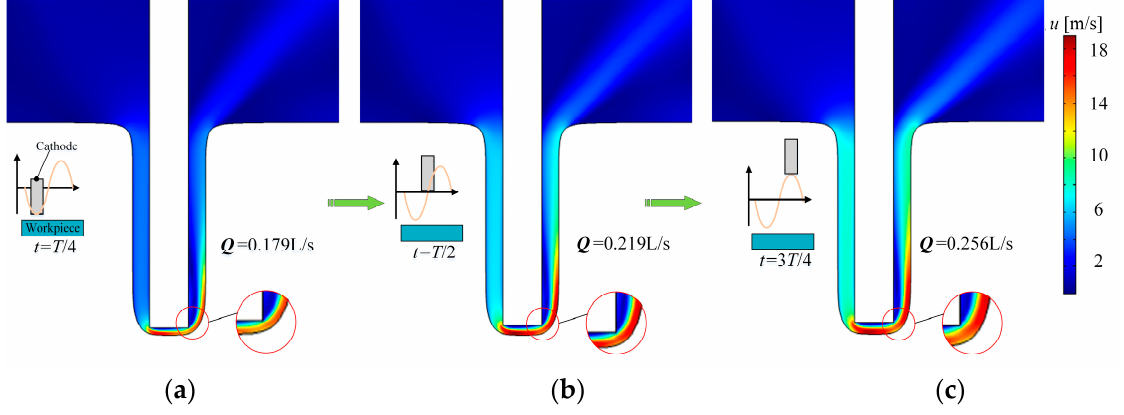
Figure 6. Distributions of electrolyte velocity over time; ( a ) t = T /4. The nearest cathode position to the anode, the maximum flow is 0.179 L/s; ( b ) t = T /2. Cathode at the middle position, the maximum flow increases to 0.219 L/s; ( c ) t = 3 T /4. Cathode at its farthest position to the anode, the maximum flow reaches 0.256 L/s.